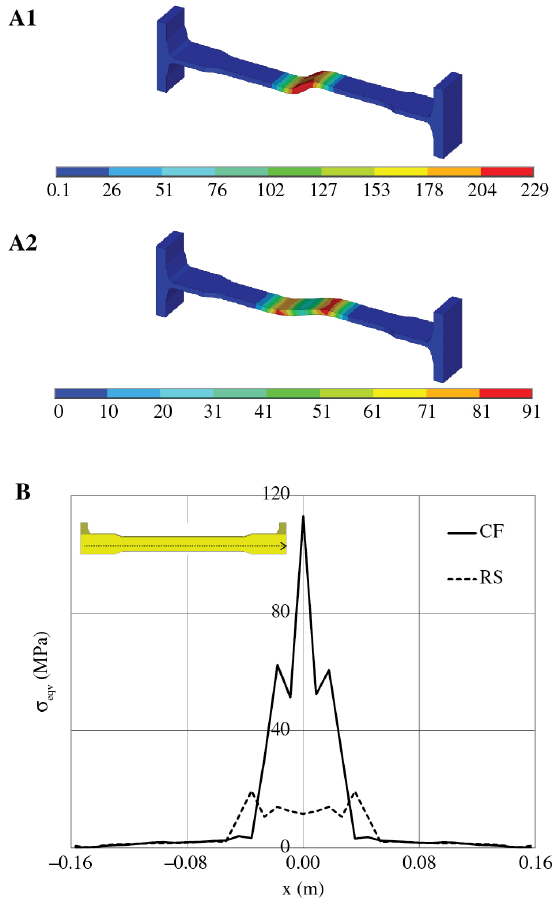
Figure 8: (A) The distribution of the equivalent von Mises stress all over the titanium connector for (A1) the CF- and the (A2) RS-types of specimen. (B) The variation of the non Mises equivalent stress along the longitudinal axis of the titanium